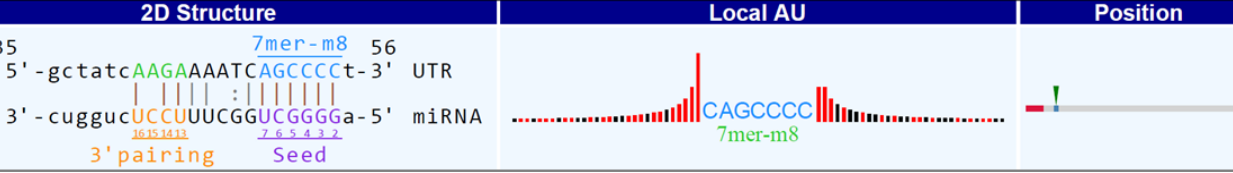
Figure 5. An example of circular RNA and its binding miRNA. The MRE type (7mer-m8), seed region, 3′ pairing, local AU, and position in the circRNA are displayed.